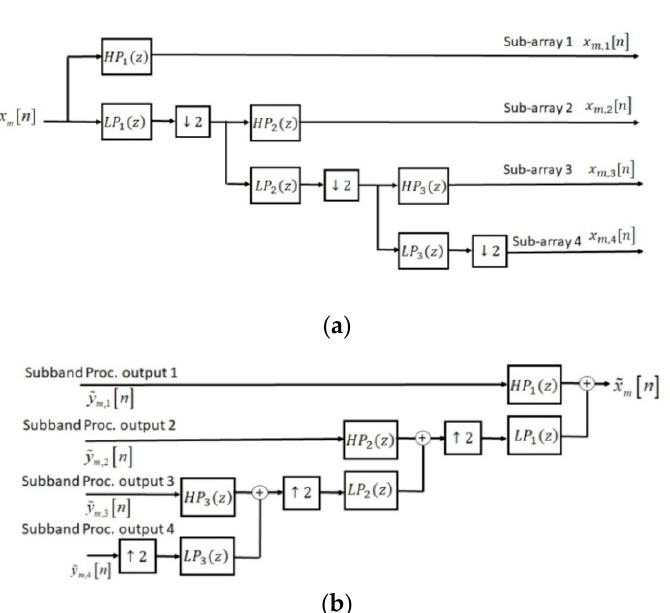
Figure 3. The tree structure for ( a ) analysis and ( b ) synthesis filters in CNMA.